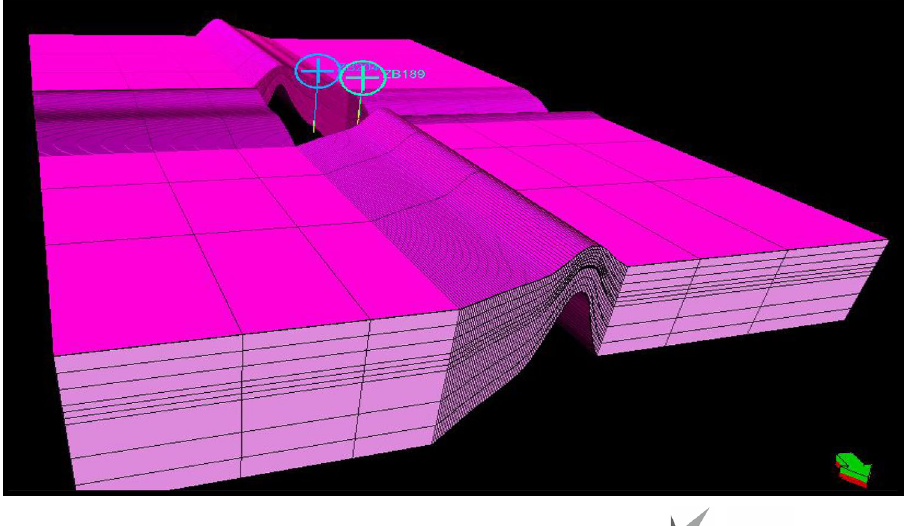
Fig. 10 Sideburden of the cre- ated geomechanical